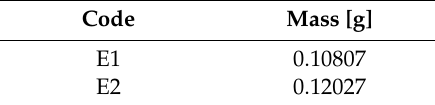
Table 11. Mass of test samples.